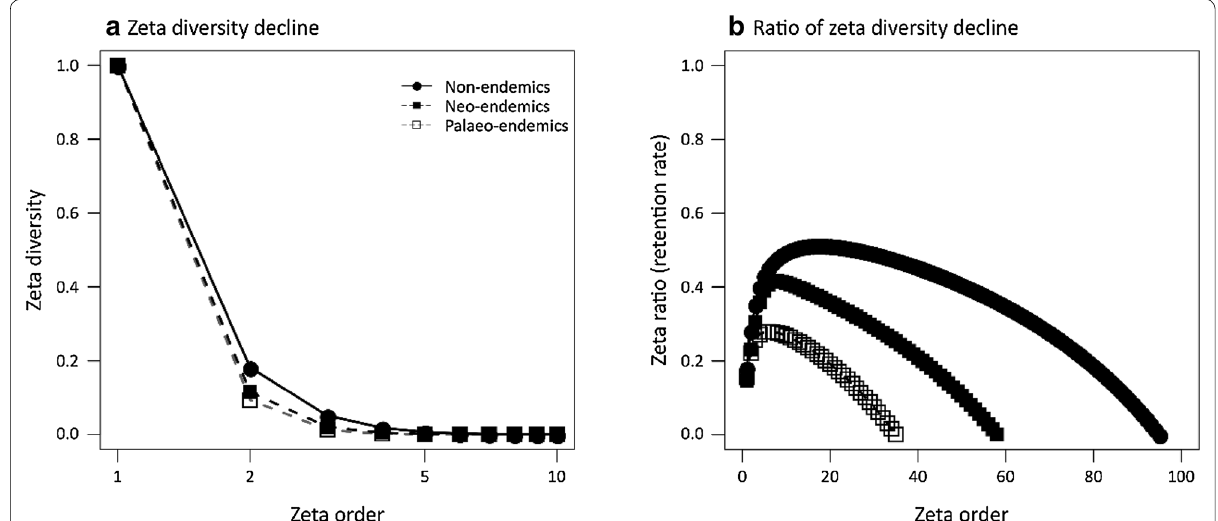
Fig. 1 The zeta diversity decline rescaled to 0–1 ( a ) and ratio of zeta diversity decline ( b ) with zeta order for non‑endemics, neo‑endemics and palaeo‑endemics vascular plants of Crete,